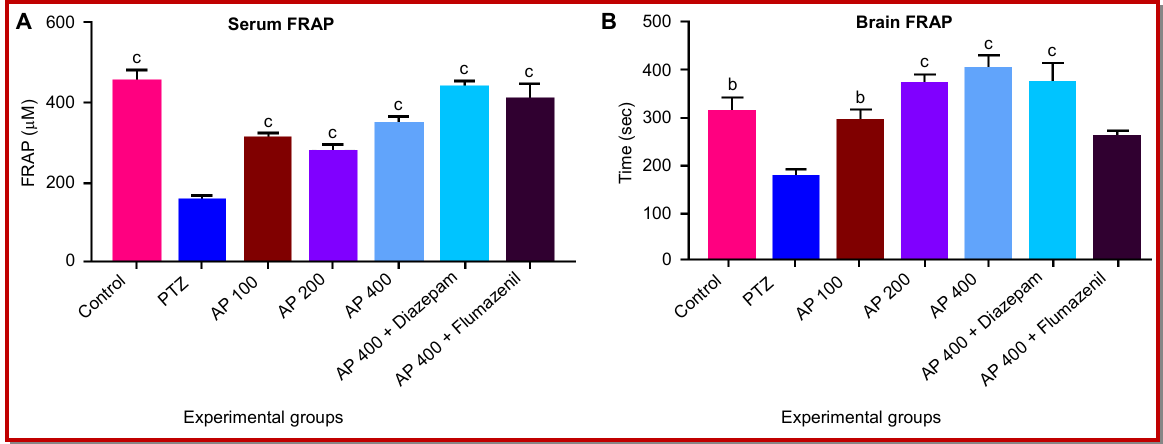
Figure 4: Comparison of total serum (A) and brain (B) anti-oxidant capacity between groups; * significant difference compared to pentylenetetrazole group ( a p<0.05, b p<0.01 and c p<0.001); AP = A. persica